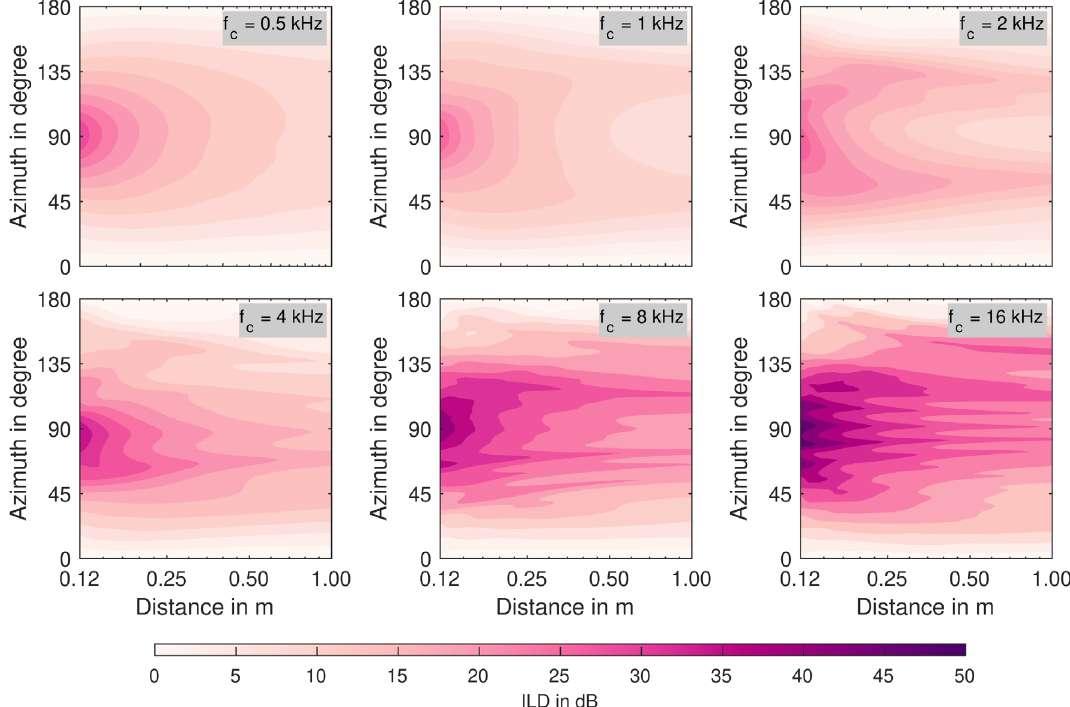
Figure 2. Horizontal plane ILDs (left hemi fi eld) of the synthesized near- fi eld HRTF sets as a function of distance for octave bands from 0.5 kHz to 16 kHz. Distances are shown on a logarithmic scale for a more detailed representation of the ILDs at close